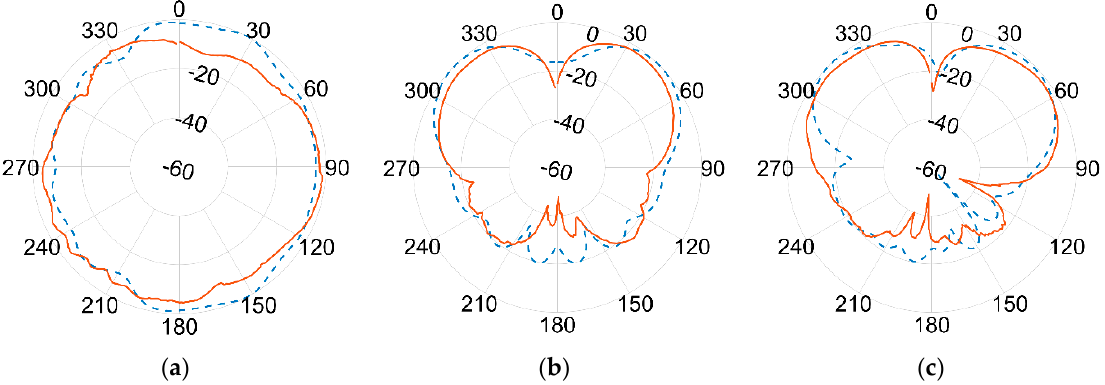
Figure 20. Normalized gain pattern of the aluminium prototype at 3.5 GHz, ( a ) XY plane, ( b ) XZ plane, and ( c ) YZ plane—Simulated (blue dashed line) and Measured (red line) data in dB.